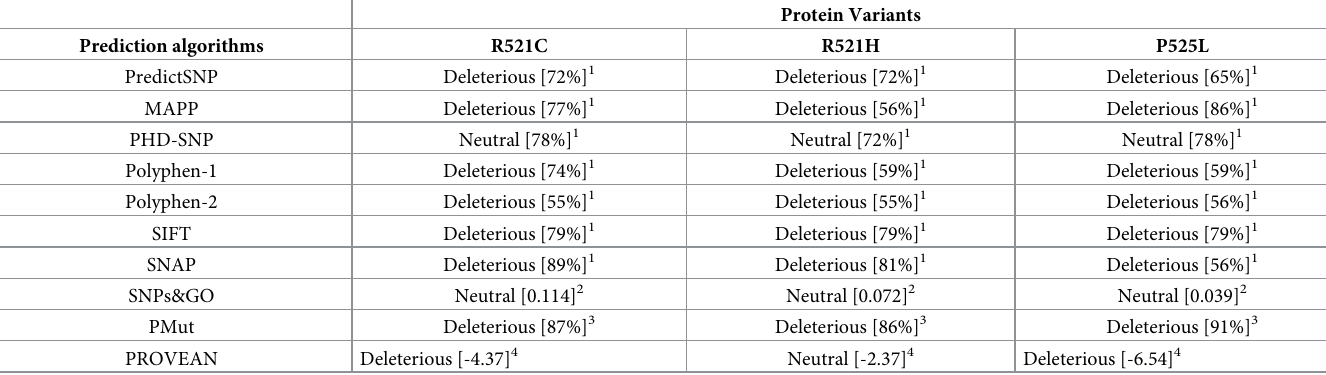
Table 1. Functional effect prediction of FUS mutations by ten nsSNP prediction algorithms.